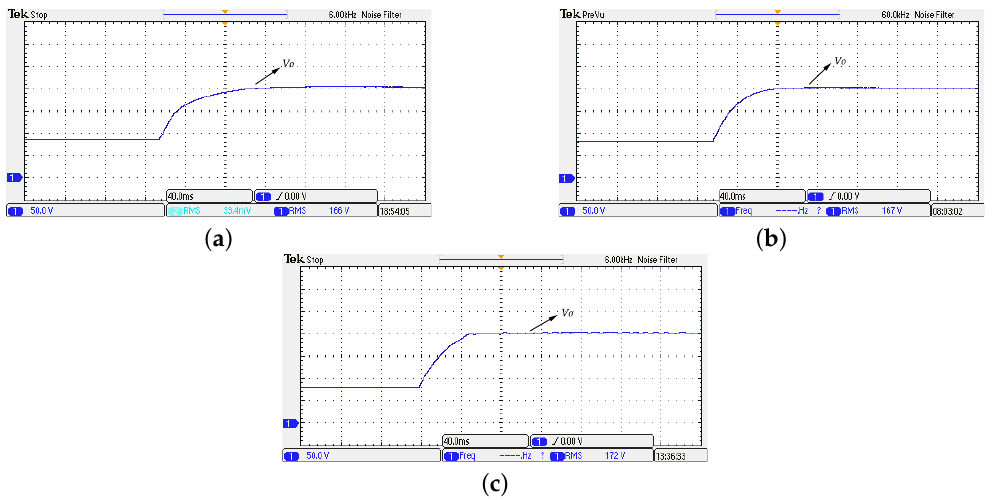
Figure 7. The experiment performance of the proposed converter: ( a ) the switching frequency against the output voltage variation; ( b ) the efficiency versus duty cycle and output voltage.